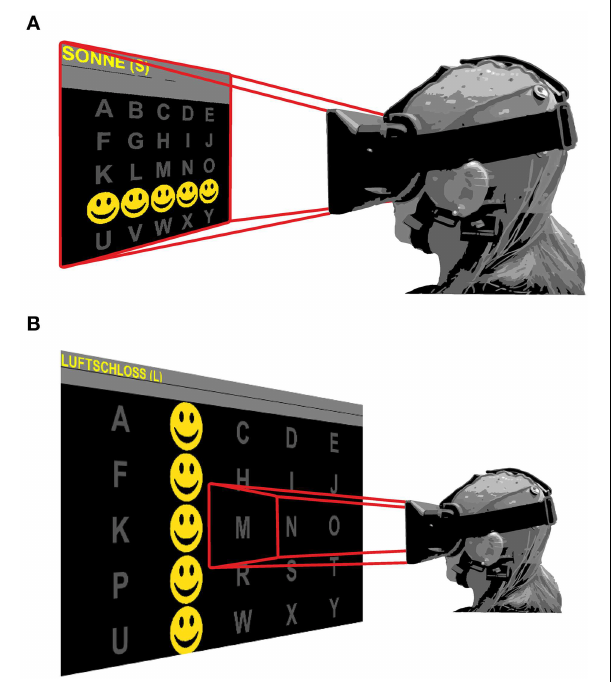
FIGURE 1 | Field of view for the glasses (A) and glasses (B) condition. In (A) the display is fixed and the user sees the whole matrix, independent of his/her viewing direction. In (B) the user sees only a limited portion of the matrix (one letter) of the matrix and has to move his head to focus on a particular letter. Rows and columns are flashed with yellow smileys during